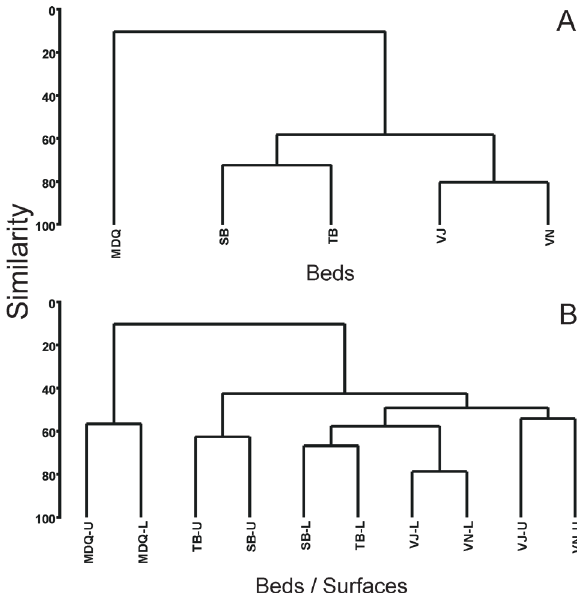
Fig. 6. – Cluster analysis of beds based on (A) square-root trans- formed coverage data of 16 multiserial species. (B) The same analy- sis, but with coverage data at each bed divided between the upper and lower valves. Abbreviations of beds as in Table 3. U: upper, L: lower.